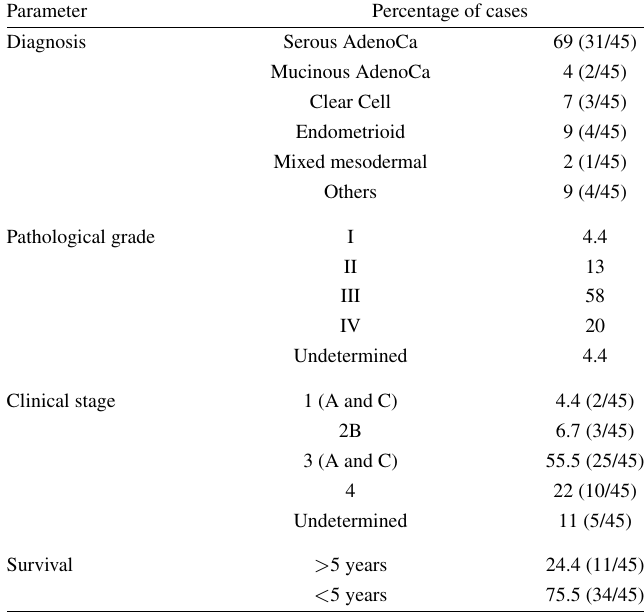
Clinico-pathological characteristics of the tumor analyzed by RT-PCR